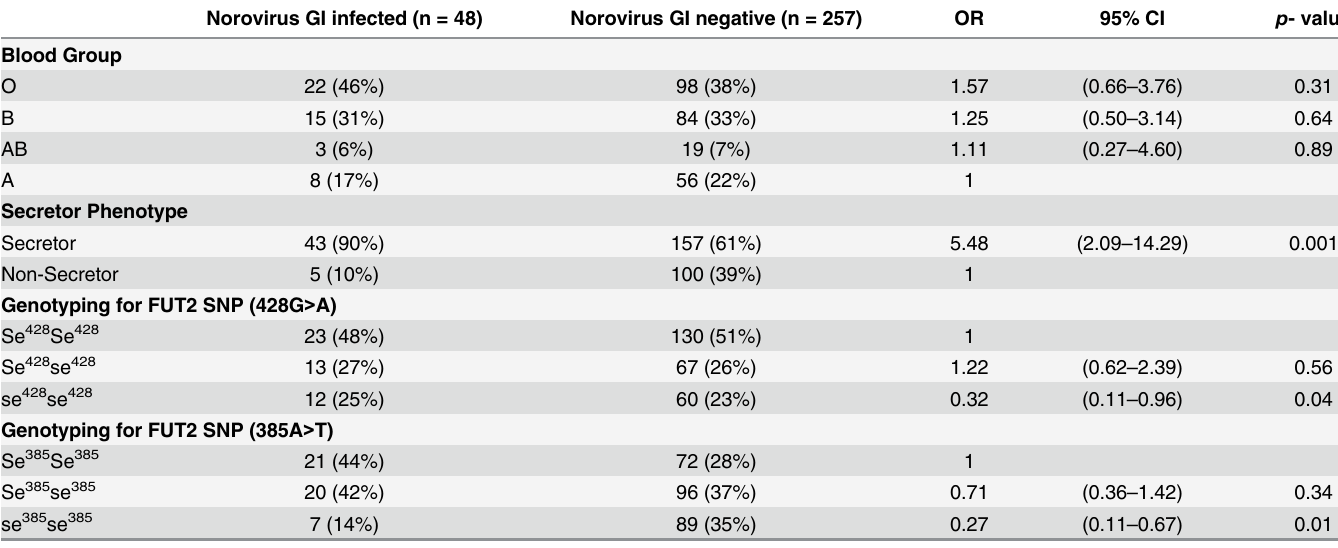
Table 4. Distribution of Histo-Blood Group and Secretor status among norovirus GI infected and non-infected individuals. Norovirus GI infected (n = 48)